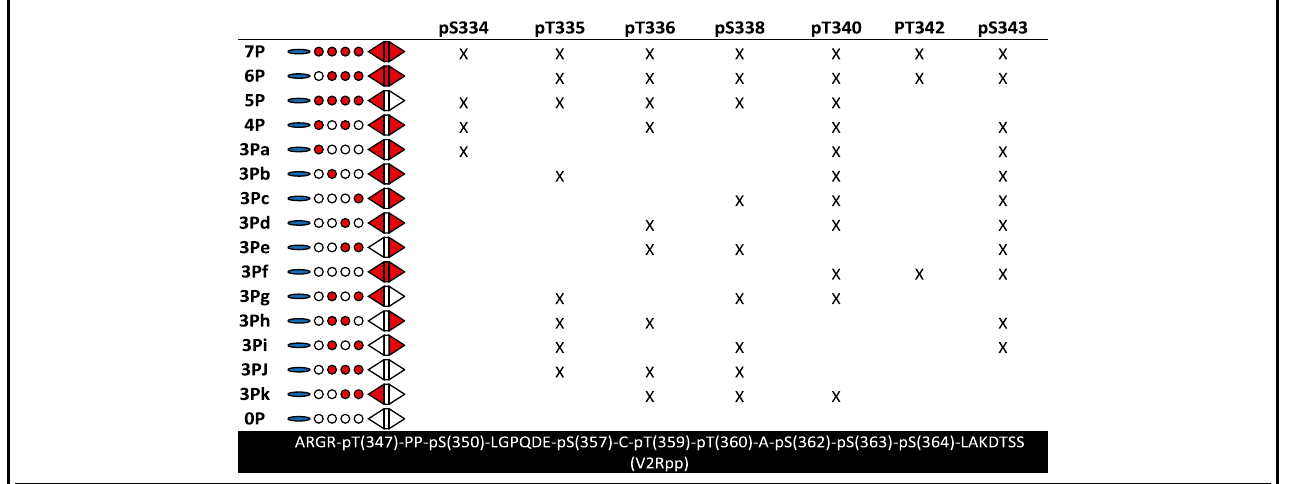
The amino acid sequence of each peptide was identical (CDDEASTTVSKTETSQVAPA), and the peptides differed only regarding which serine and threonine residues were phosphorylated. The peptide sequence was derivedfrom the bovine rhodopsin C-terminus withan N-terminalcysteineintroduced toallow fl uorescent labelingof the peptides.Thefully phosphorylatedC-terminus of V2 vasopressin receptor (V2Rpp, sequence indicated in black box) was included to have an additional reference in the trypsin digest assay and the fl uorescence anisotropy experiments. For fl uorescence anisotropy experiments, the V2Rpp was fl uorescently labeled during the chemical synthesis at the N-terminus of the peptide